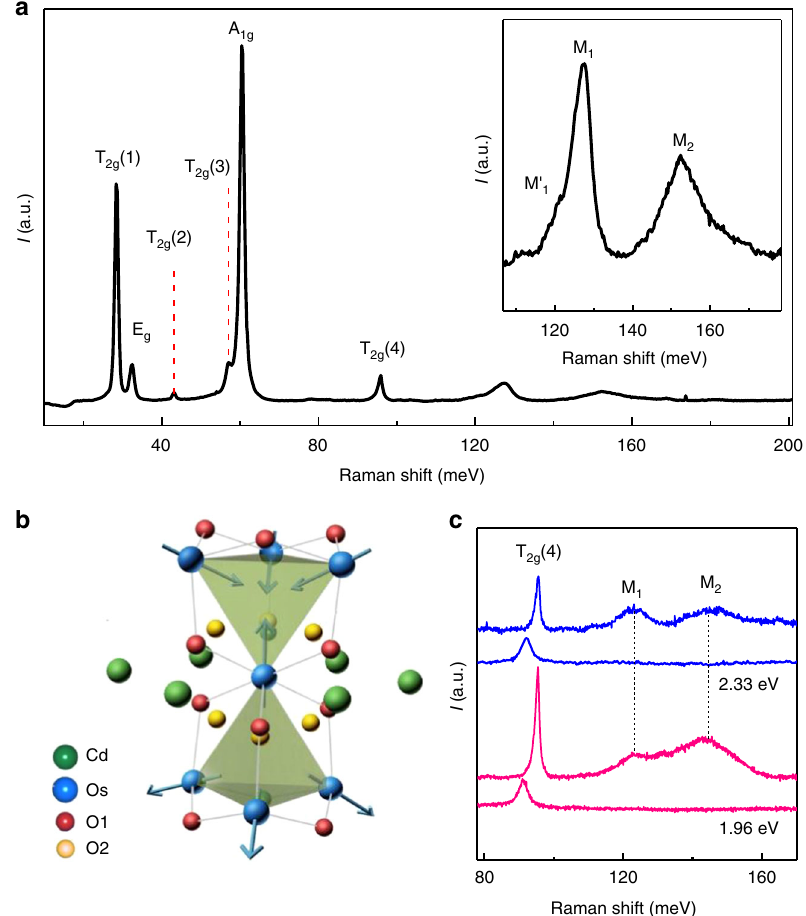
Fig. 1 Raman spectra of Cd 2 Os 2 O 7 obtained at low temperature. a is the Raman spectrum obtained at 15 K under 2.33 eV excitation laser. The spectrum shows six Raman active Γ -point phonon modes with symmetries A 1g +E g + 4T 2g . Inset of a is a detail showing the broad peaks located in the frequency region between 105 – 175 meV. Three inelastic features are resolvable: M 1 at ~127 meV, M 2 at ~152 meV and the shoulder M 1 ’ at ~121 meV. b is the pyrochlore lattice structure showing the Os ( blue ) tetrahedra with AIAO magnetic ordering ( blue arrows ). In AIAO magnetic order, the transition metal spins belonging to a given tetrahedron either all point directly towards or away from the tetrahedron ’ s center. The Cd ions are in green . Trigonally compressed cages of oxygensO(1) ( red ) surround each Os, and the oxygens O(2) ( yellow ) are bonded to Cd. c is the Raman spectra obtained at 100 K and 240 K under 2.33 eV and 1.96 eV excitations. The blue spectra and pink spectra were obtained under 2.33 eV and 1.96 eV, respectively. For each excitation, the top spectra were measured at 100 K and the bottom spectra were measured at 240